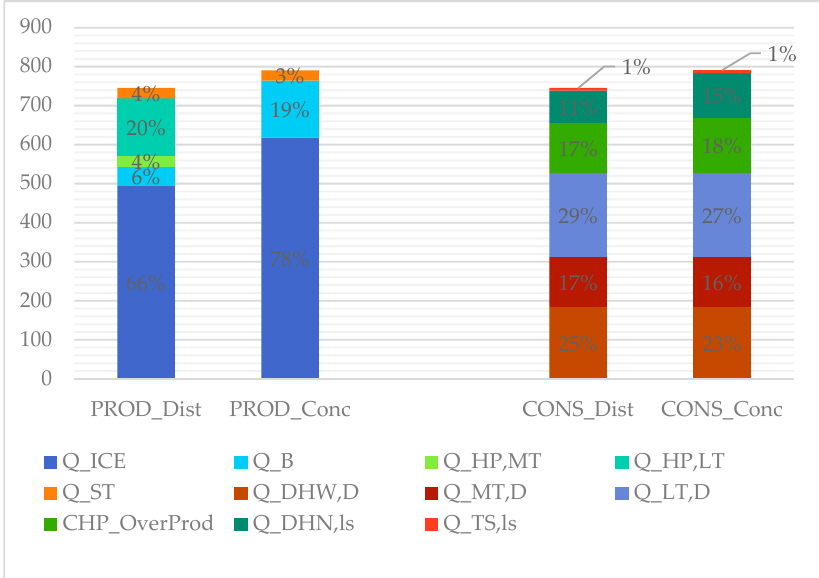
Figure 7. Thermal energy balance (MWh/yr).